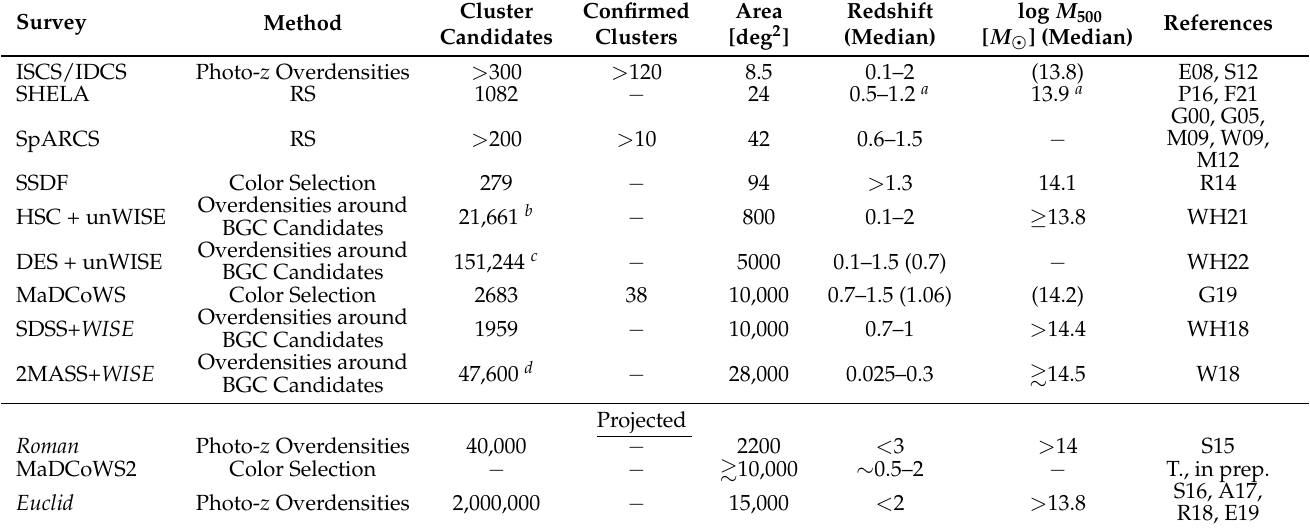
Table 1. A(n Incomplete) List of Large Cluster Surveys Incorporating Near-Infrared Observations (Section